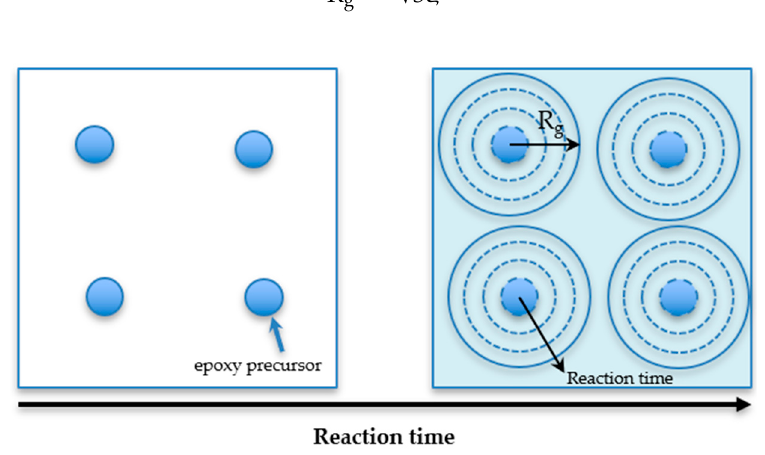
Figure 4. The transition of epoxy nanodomains through reaction time.